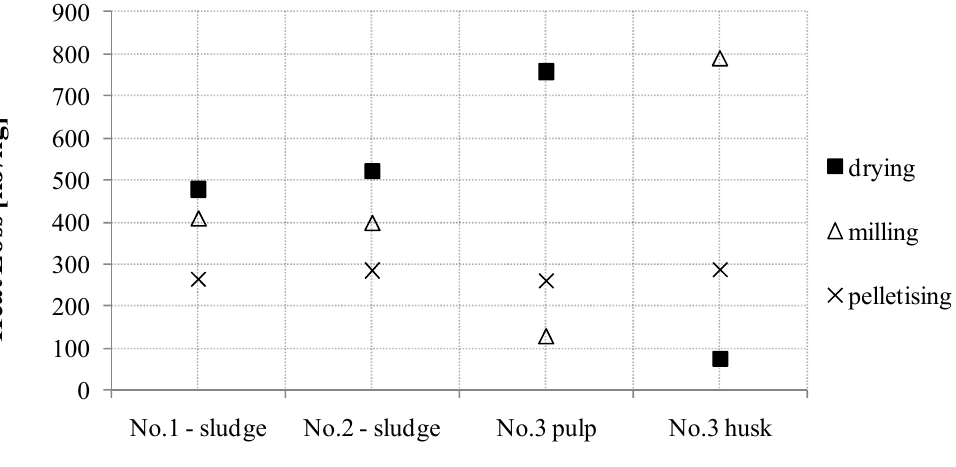
Figure 4. Energy consumption for stabilization of